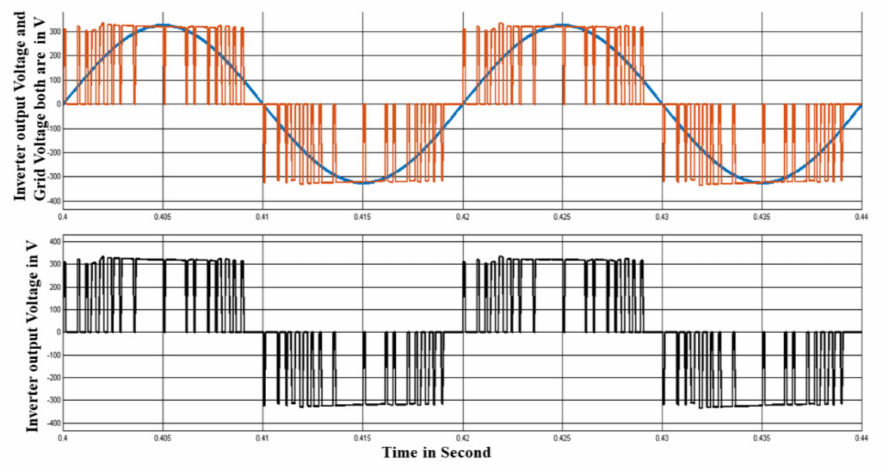
Figure 12. SPWM inverter output voltage with grid synchronization.